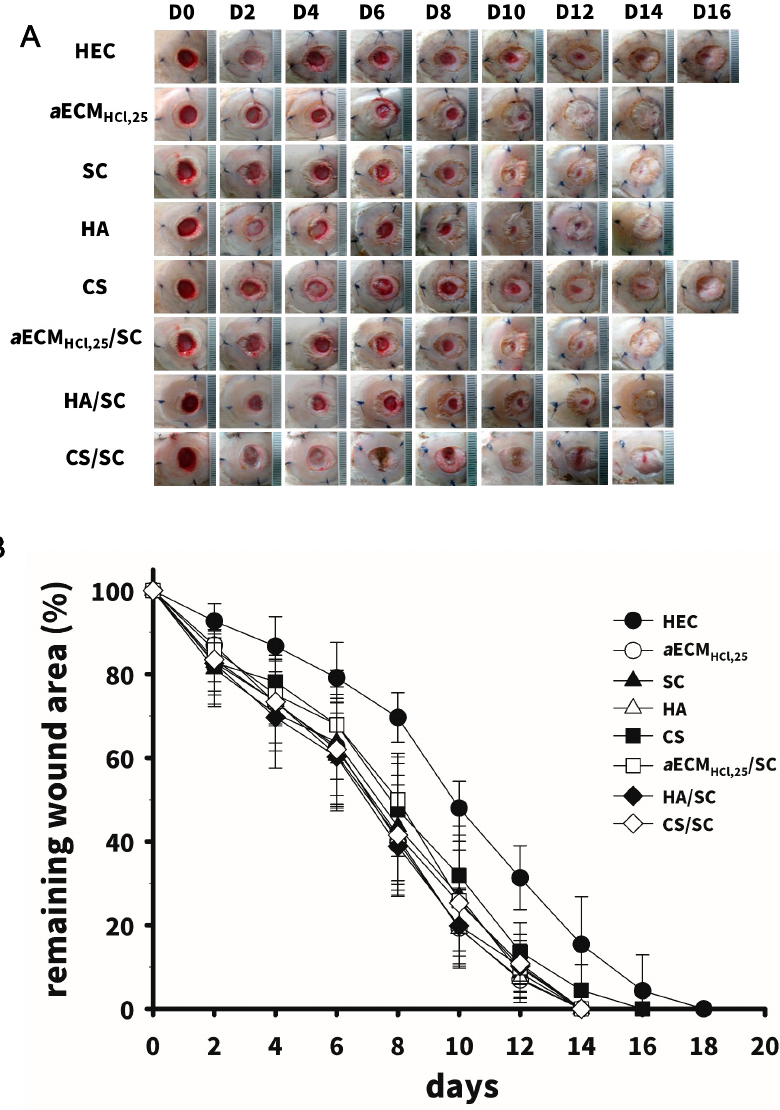
Figure 6. Wound-healing studies ( n = 4~6) in diabetic rats showing the patterns of the healing process vs. time ( A ) with five kinds of hydrogel dressings including HEC, CS, SC, HA and a ECM HCl,25 and three kinds of composite hydrogel including a ECM HCl,25 / SC, HA / SC and CS / SC (C); ( B ) The remaining wound area vs. time profiles. Values are presented as the mean ± standard deviation. * p < 0.05, compared to H 2 O.